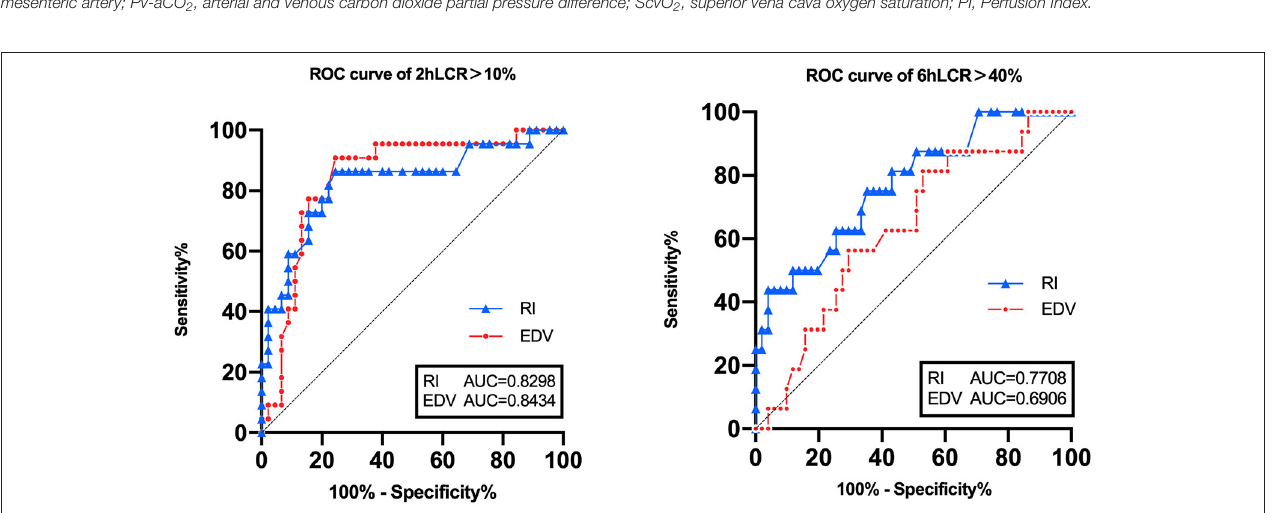
FIGURE 3 | Receiver operating characteristic curves comparing the lactate kinetics’ ability to predict superior mesenteric artery resistance index and end-diastolic